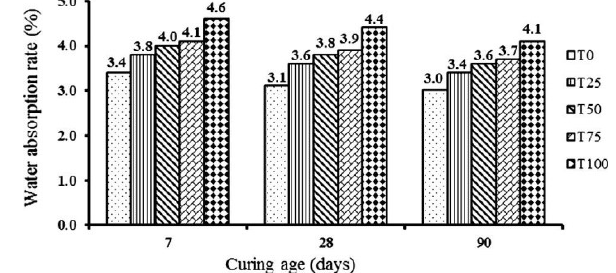
Figure 6: Water absorption in concrete with and without iron ore tailings